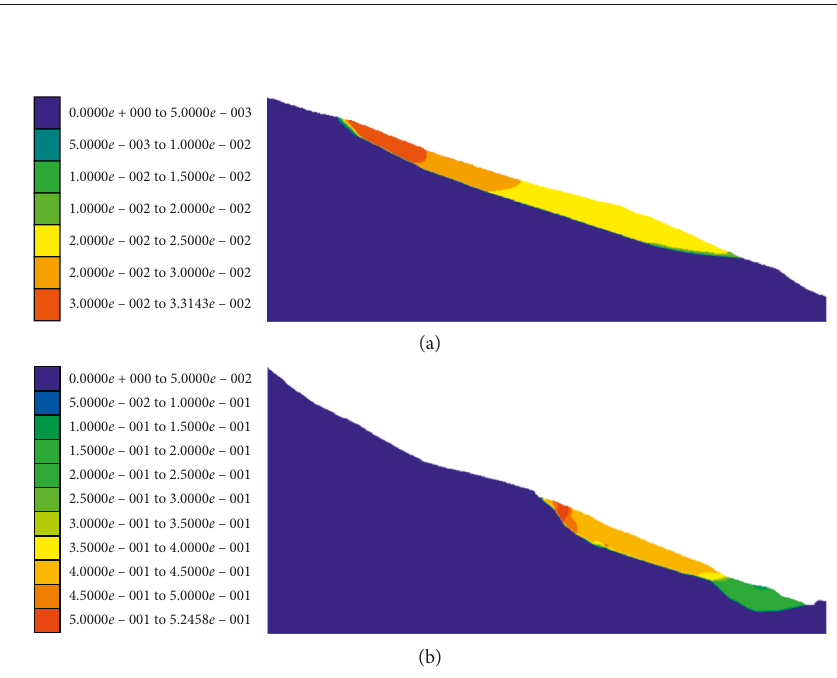
Figure 8: Finite element analysis based on the back analysis results. (a) Cangjiangqiao. (b) Dahua. Table 8: Comparison of measured displacement with that obtained based on the back-analyzed strength parameters of slip surface.